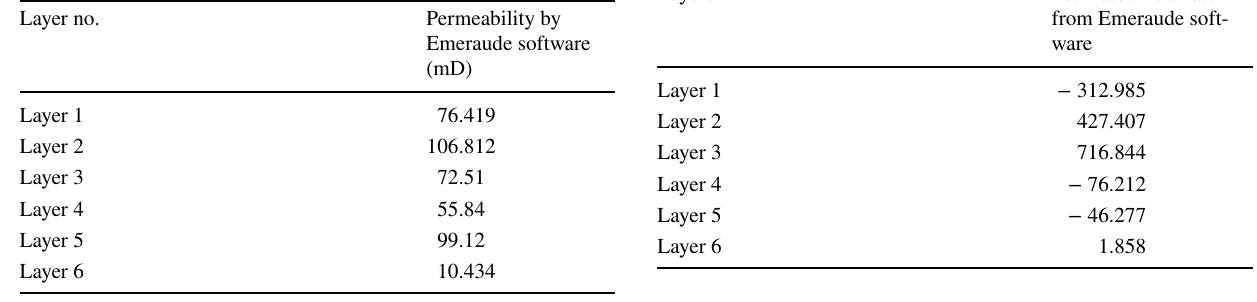
from Emeraude soft-